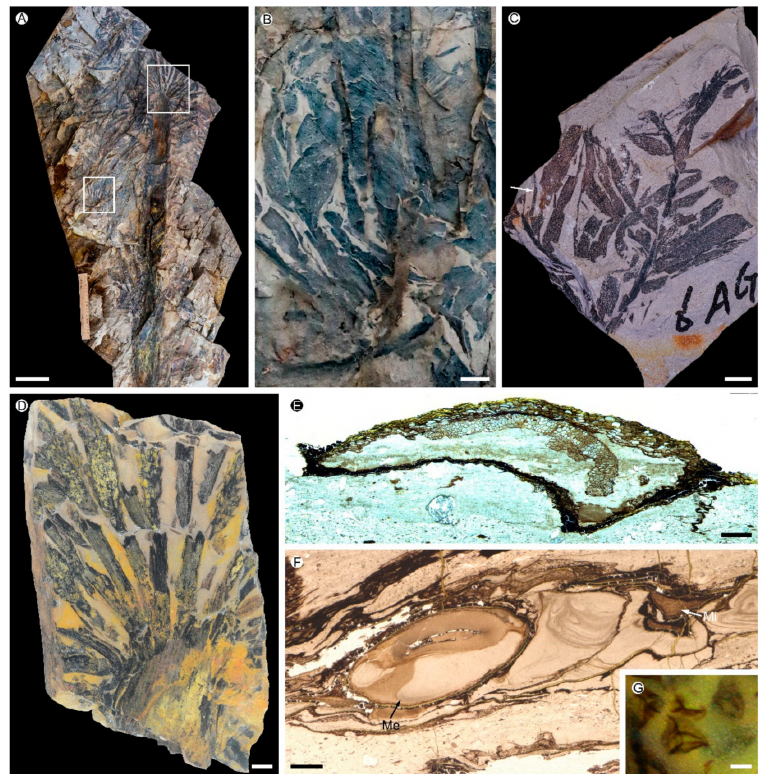
Figure 2. Tingia unita from Wuda Coalfield, Inner Mongolia. ( A ) Overall morphology of T. unita , both compound leaves and strobili are directly attached on the same stem, scale bar = 10 cm. ( B ) Enlarge- ment of the left white box in ( A ), showing the large pinnules, scale bar = 1 cm. ( C ) Large pinnules and small pinnules (arrow) of T. uniata , scale bar = 1 cm. Collection number: PB201694. ( D ) Enlargement of the area within the right white rectangular frame in ( A ), showing the stem part with anatomy examined, scale bar = 1 cm. Collection number: PB201150. ( E ) Showing the C-shaped vascular bundle in rachis of compound leaf, scale bar = 500 µ m. Collection number: PB201150; slide number: PB201150-1. ( F ) Showing the megasporangia (Me) and microsporangia (Mi), scale bar = 500 µ m. Collection number: PB201150; slide number: PB201150-1. ( G ) Showing the microspores with trilete mark from ( G ) (indicated by the white arrow), scale bar = 10 µ m. Collection number: PB201150; slide number: